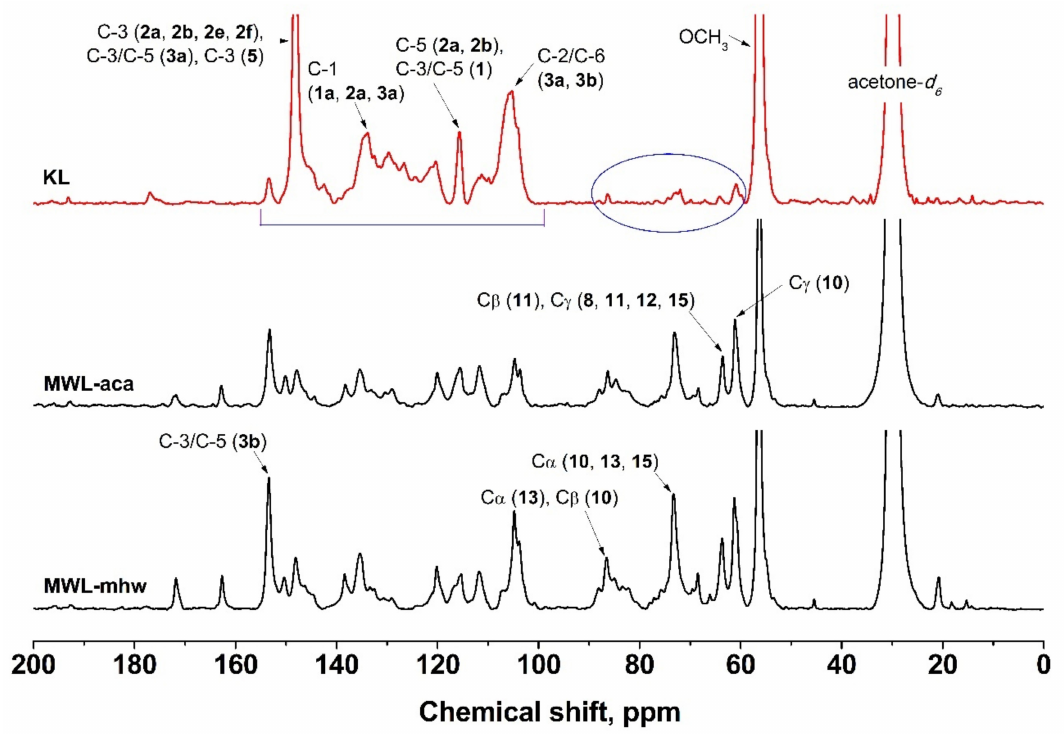
Figure 5. 13 C NMR spectra of KL and